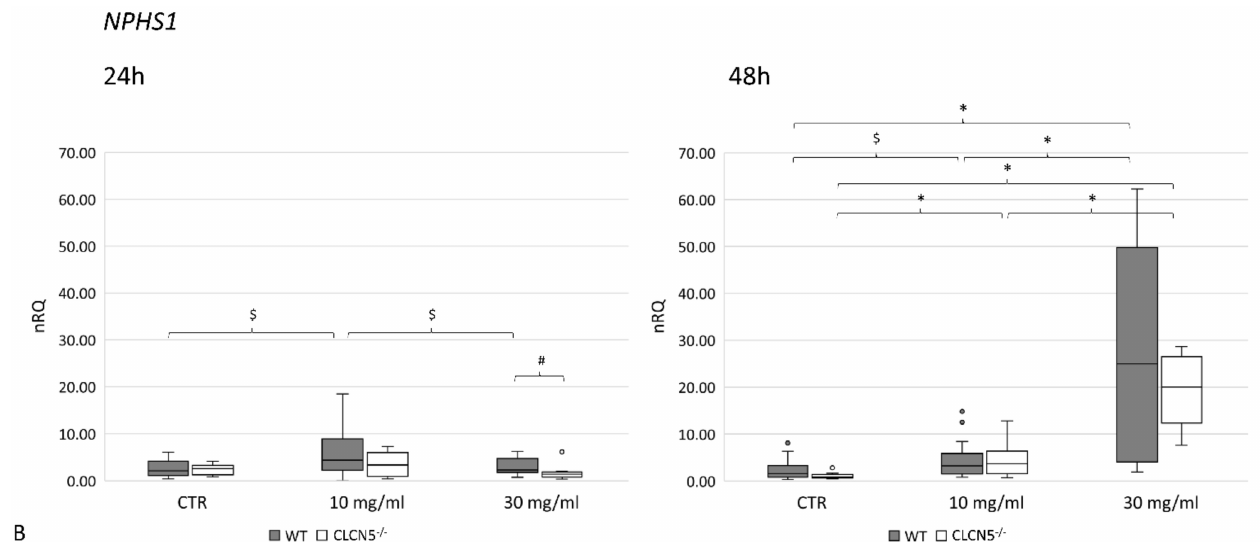
Figure 10. Nephrin expression in WT and CLCN5 − / − clones following albumin treatment (10 mg/mL and 30 mg/mL) at different time points (24, 48, and 72 h). Boxplots show medians and interquartile ranges of ( A ) protein expression, as determined by ICW and ( B ) relative mRNA, as determined by qRT-PCR. p -values were obtained with the Mann–Whitney U test. * p < 0.001; # p < 0.01; $ p < 0.05. Results are from two independent experiments performed in triplicate (RT-PCR) and in quadruplicate (ICW). Abbreviations: nRQ: normalized relative quantity; OD, optical density.